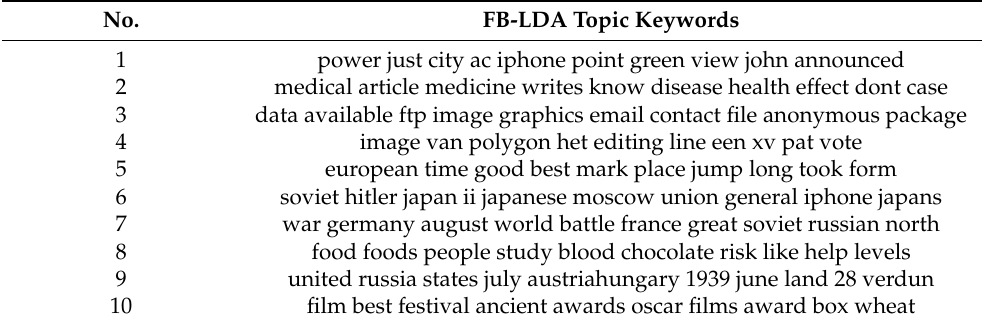
Table 6. FB-LDA (K = 10) results for 10 Newsgroups